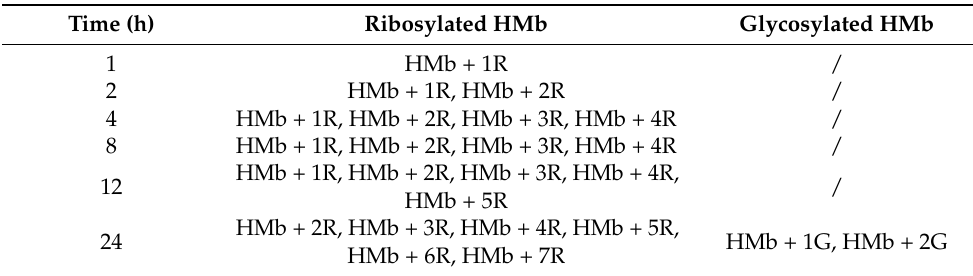
Table 1. The protein glycation products of HMb as induced by D -ribose or D -glucose at different reaction times.